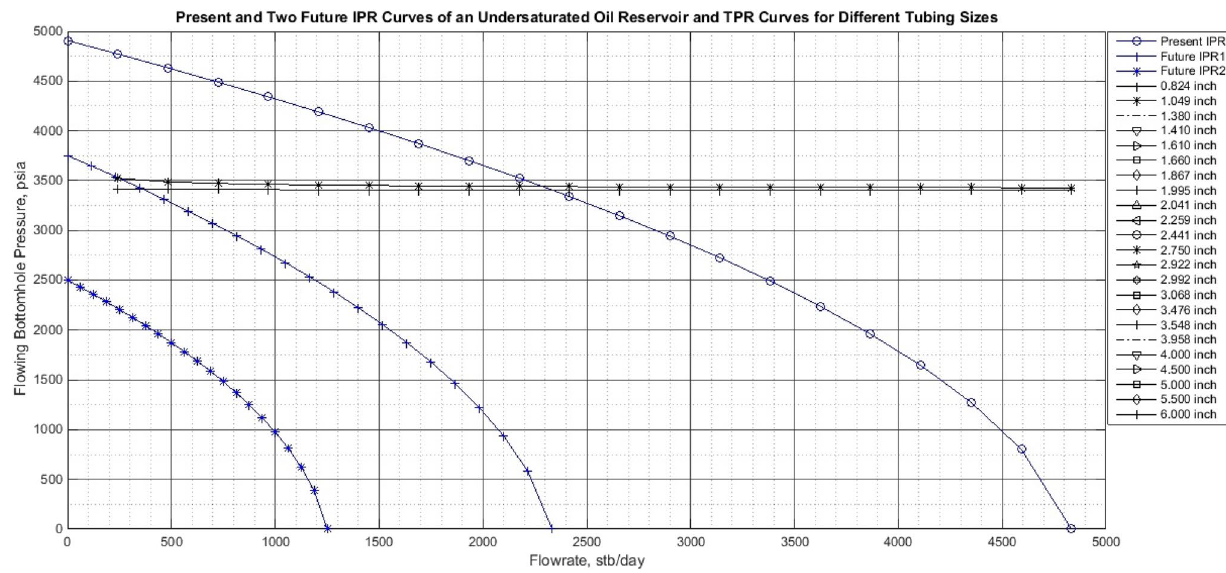
Fig. 7 Comparison of operating rates of selected 2.75-inch OTS and 6-inch tubing size for undersaturated oil